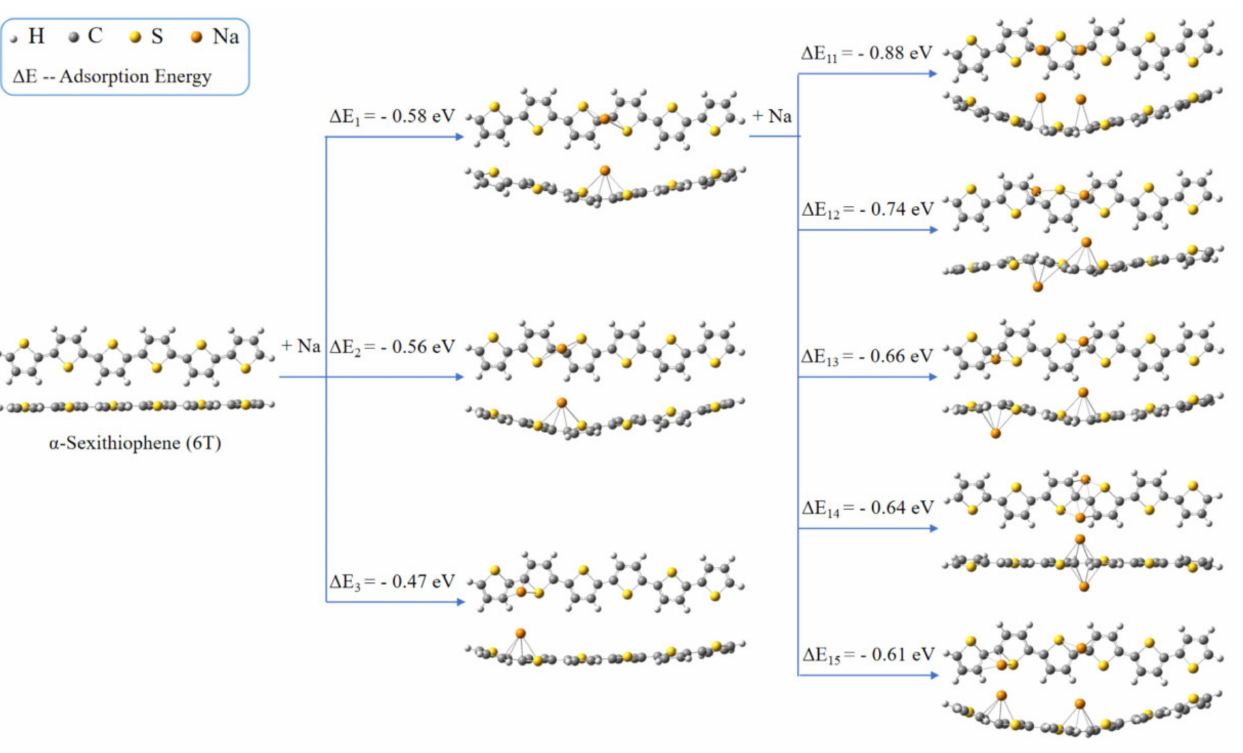
Figure 6. Calculated adsorption energy ( ∆ E) of optimized 6T-Na and 6T-Na 2